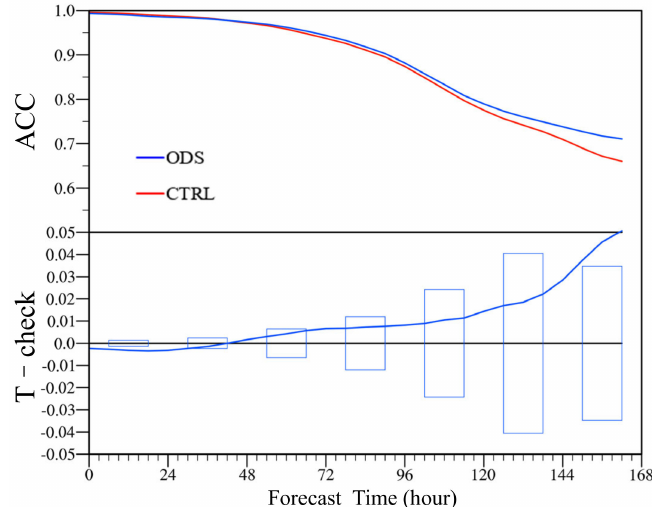
Figure 11. Same as Figure 10 except for the ACC between the FNL data and the rolling forecasts of the two experiments from 0300 UTC 7 August 2019 to 2100 UTC 10 August 2019 at 6-h